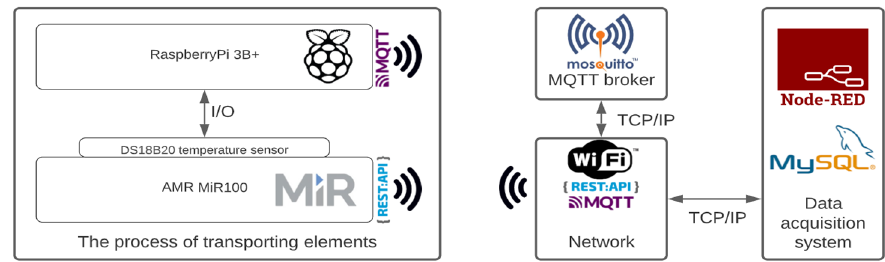
Figure 2. Structure of data acquisition and generation of predictive functions.